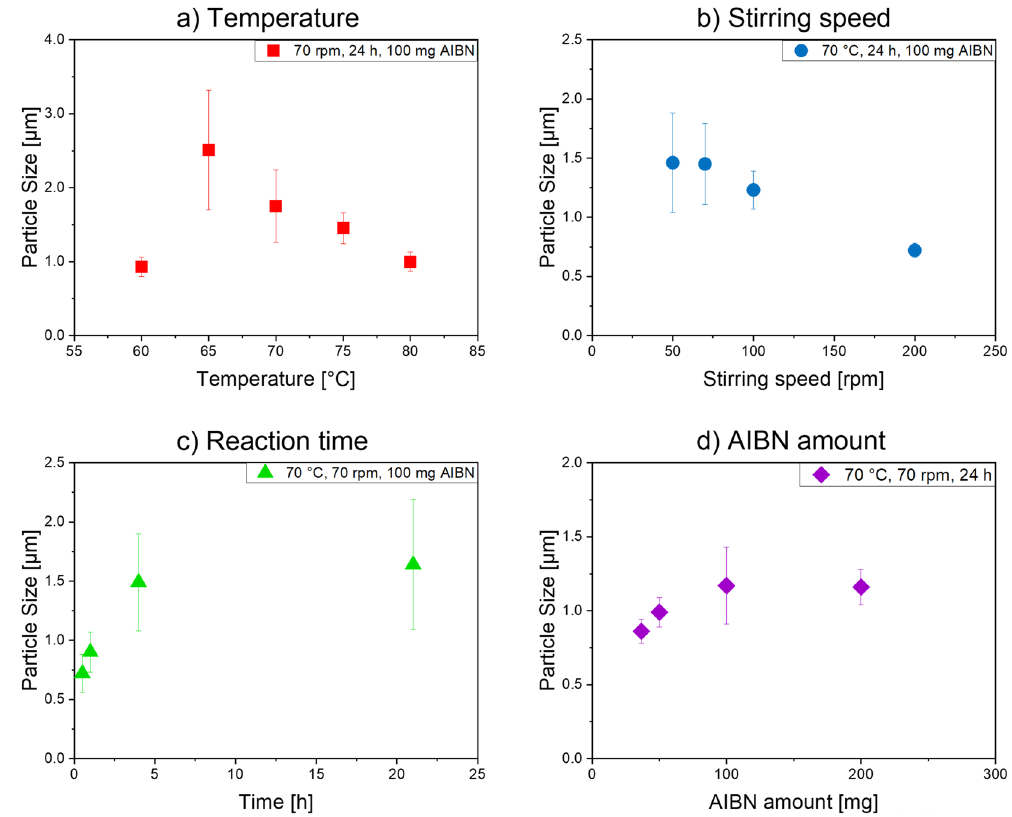
Figure 7. Particle size of DVB-crosslinked PS microbeads encoded with OBDAC-coated, OA/OLA-stabilized CdSe/CdS-QDs, as determined by DLS, obtained as a function of systematically varied ( a ) reaction temperature, ( b ) stirring speed, ( c ) reaction time (samples not purified), and ( d ) amount of AIBN. In all cases, 36.6 mg PEG- b -PCL in toluene and the same amount of OBDAC-coated, OA/OLA-stabilized CdSe/CdS-QDs were